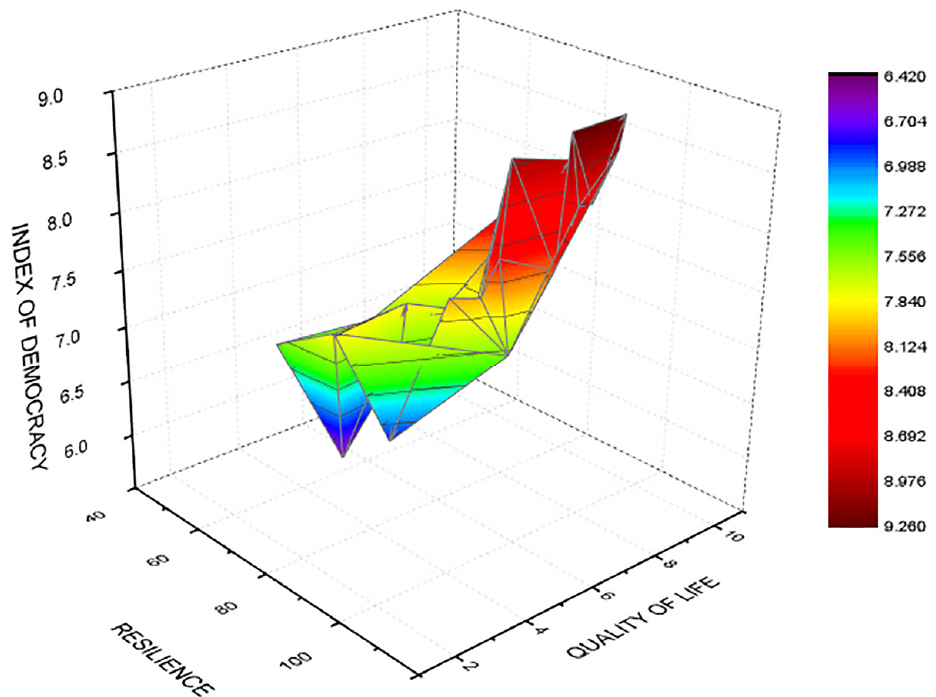
Figure 7. Vectors’ space for Democracy Index, Resilience and Quality of Life. Author’s quantitative determination based on statistical data presented in Section 2 (Research Methods).